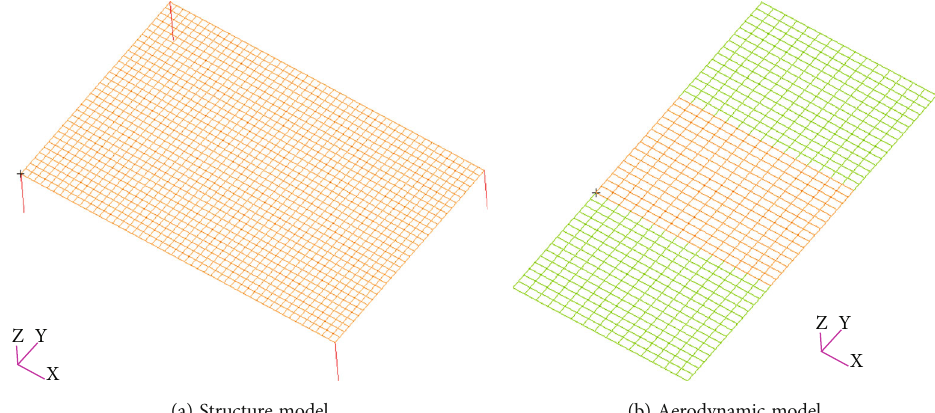
Figure 4: Structural model and aerodynamic model.